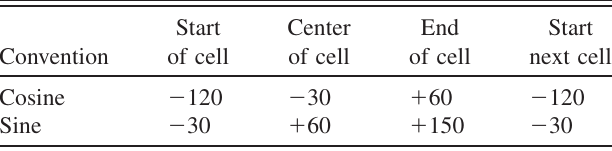
TABLE III. Phases in cell 33 for (cid:6) s ¼ (cid:1) 30 (cid:2) of PARMTEQM